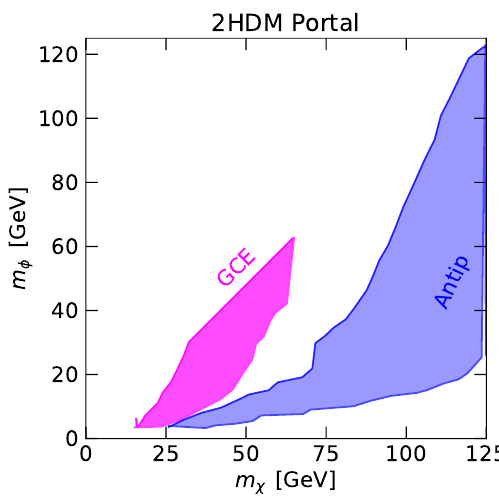
Figure 9 . As in (cid:12)gure 5, but for the case of hidden sector dark matter that annihilates to particles that decay through the 2HDM portal, considering a Type-II model with tan (cid:12) = 1 and sin (cid:11) =